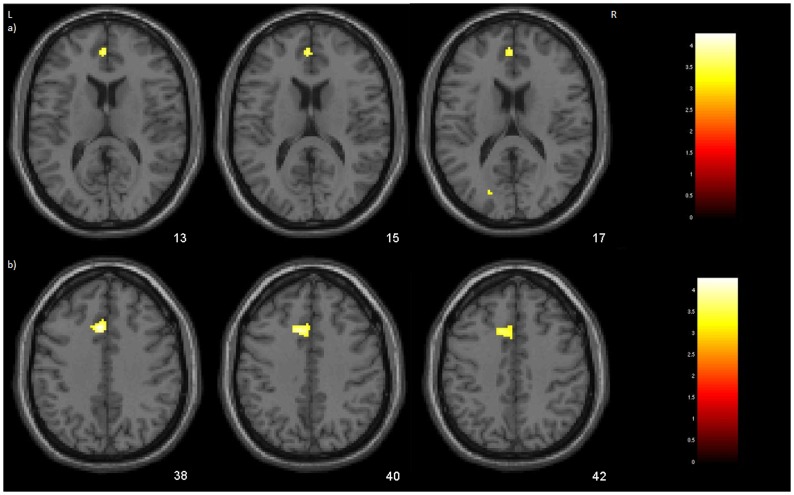
Between-group differences in the pattern of linear correlation between GM volume and age.Results from the inclusion of “group status” as a predictor variable in the analysis investigating within-group correlations between rGM volumes and age across the High and Low education samples. Foci of significance were overlaid on axial brain slices spatially normalized into an approximation to the Tailarach and Tournoux stereotactic atlas (1998). The numbers associated with each frame represent standard coordinates in the z-axis, indicated in MNI (Montreal Neurological Institute). a) One cluster of significant relative loss with aging in low education elders compared with high education subjects was detected in the left anterior cingulate cortex (p<0.05, FWE-corrected for multiple comparisons); b) trend towards more pronounced direct correlation between rGM and aging in the low education than the high education group in the left frontal dorsal region (p<0.10, FWE-corrected). Details for each cluster are provided in Table 2 including coordinates of voxels of maximal statistical significance and their peak Z-score; L = left; R = right.